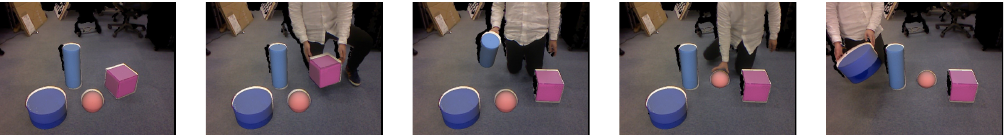
Figure 1. Our method estimates the shape, size, and the pose of the primitive shaped objects in the scene and the detected objects are tracked sequentially. The results of pose estimation is overlaid onto the RGB image for the visualization, and we do not use any color information, but only use the depth